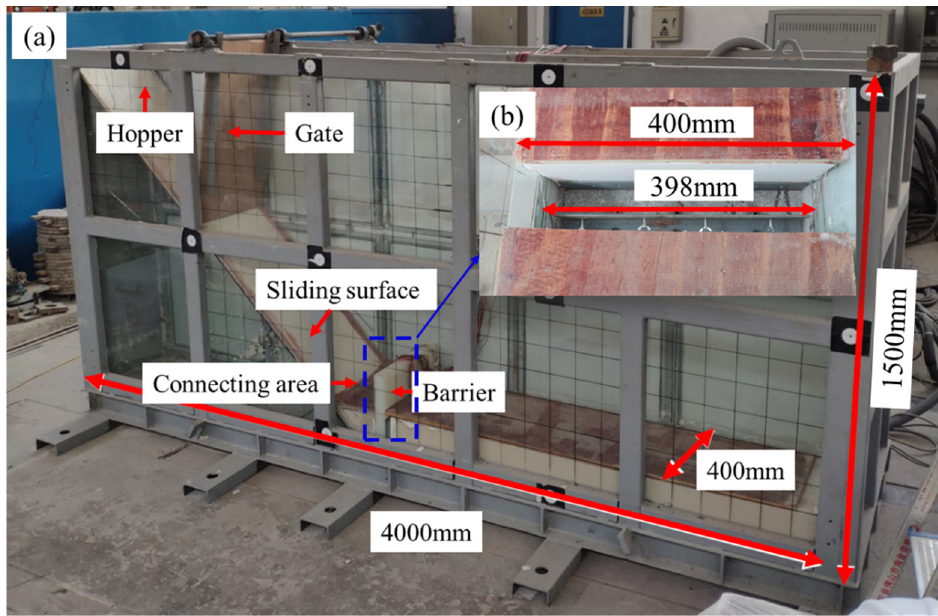
Figure 1. ( a ) Photograph of physical flume modelling instrumentation; ( b ) fixing bolts at the bottom of the barrier.